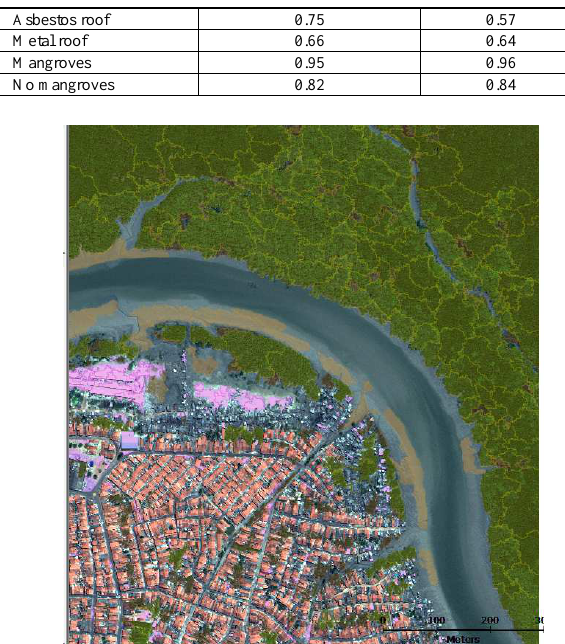
Figure 10: Final classification of the scene. Texture attributes implemented at InterIMAGE v1.27 were used for classification, taking into account the difference among classes related to it. The result of the scene classified was improved because the attributes related to both channels Yellow and Red-Edge are better defined, eliminating confusions which occurred in the past, for instance, with classes Ceramic roof and Bare soil.